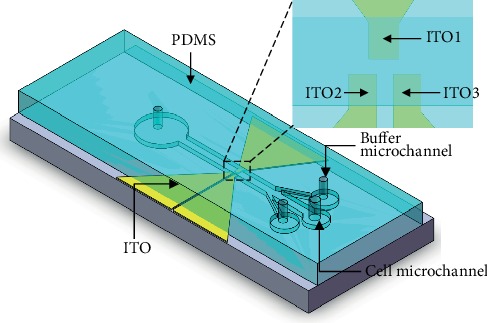
Scheme of microfluidic chip. Microfluidic chip consisting of three ITO electrodes and three microchannels.